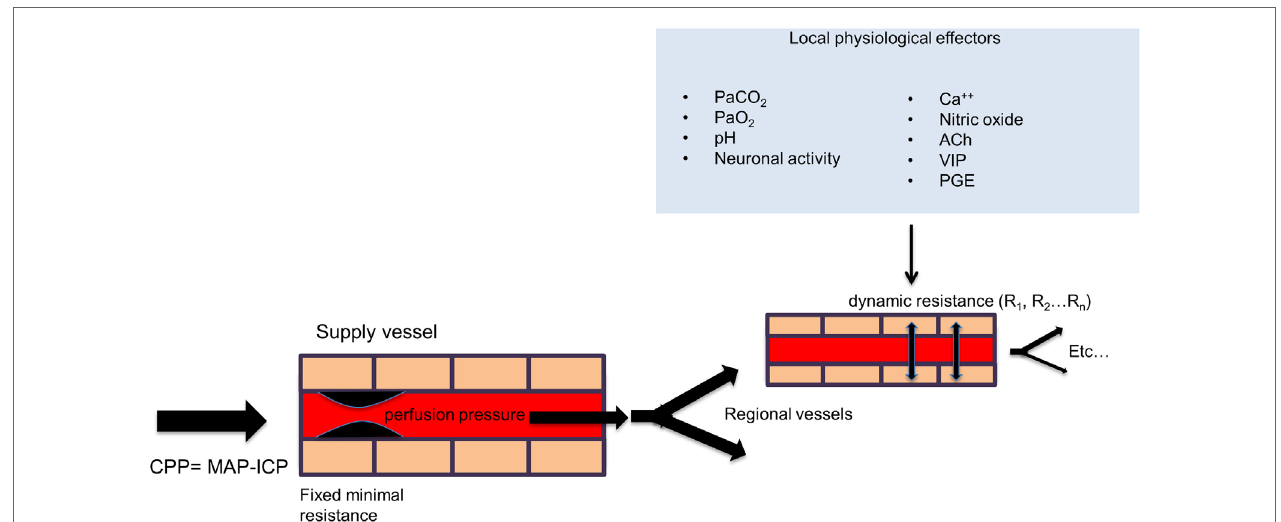
FiGUre 1 | General schema of cerebral perfusion . Intracranial vessels are perfused in parallel in a fractal branching pattern. The net flow in each region is dynamically determined by the net flow resistance of each branch. Under normal conditions, the inflow from major extracranial vessels is not limiting. The flow to each vascular region is controlled by its local factors as shown in the figure. The net effect of regional vascular resistances determines the total cerebral blood flow. However, with a strong global vasodilatory stimulus, the drop in resistance in the collective downstream branches can be reduced to the point where the blood flow in the larger supply vessels is limiting (“fixed minimal resistance” in supply vessel in the figure). Abbreviation: CPP, cerebral perfusion pressure; MAP, mean arterial pressure; ICP, intracranial pressure; PaCO 2 , arterial partial pressure of carbon dioxide; PaO 2 , arterial partial pressure of oxygen; Ca ++ , calcium ions; ACh, acetylcholine; VIP, vasoactive intestinal polypeptide; PGE,